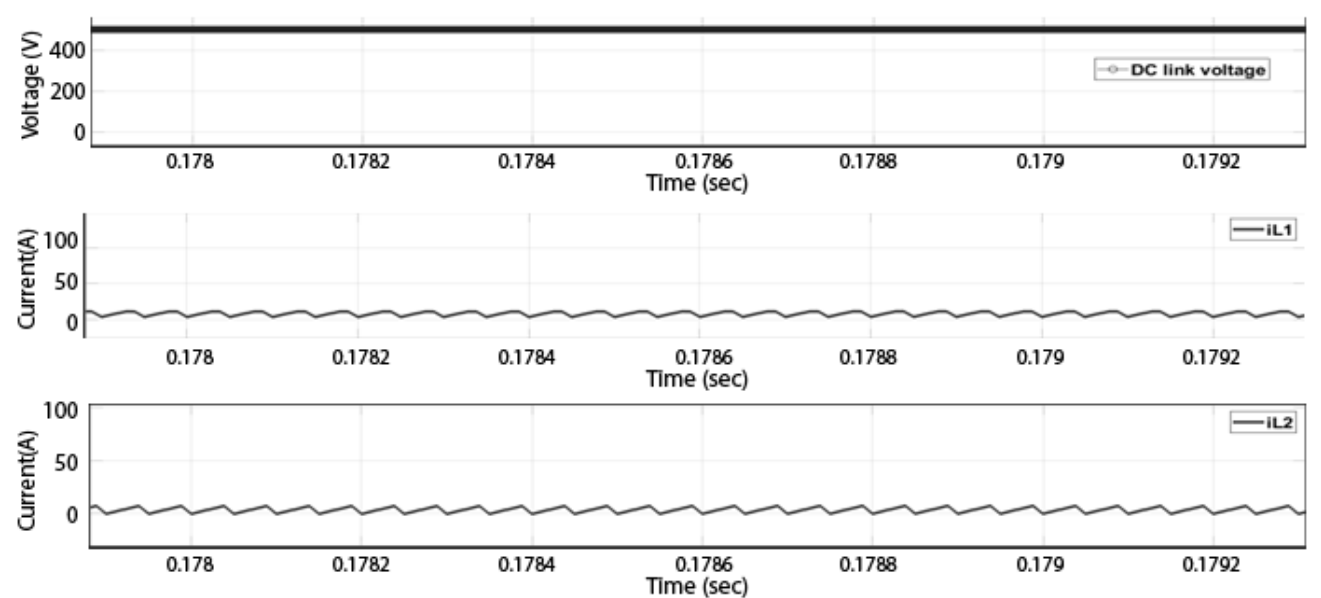
Figure 11. ( a ) SOC, voltage, and current of supercapacitor in mode 3(a). ( b ) SOC, voltage, and current of battery in mode 3(b).